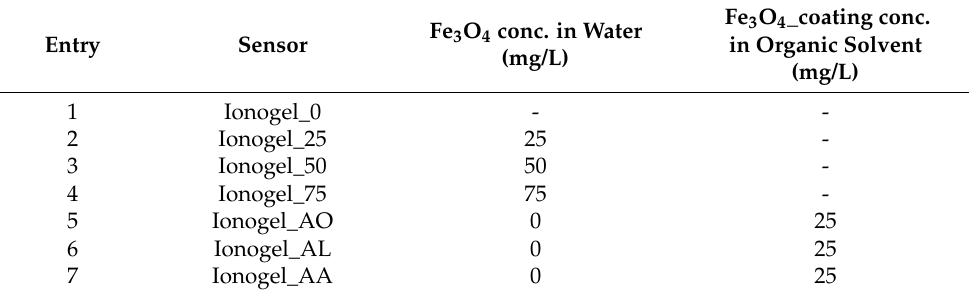
Table 1. Preparation of the ionogels.